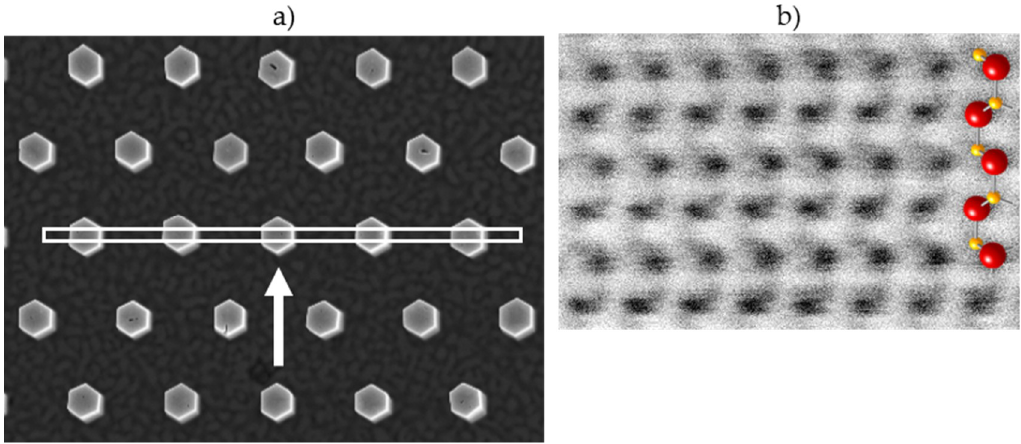
Figure 4. ( a ) Schematic of the STEM lamellae position on sample N–AlGaSL-1; the arrow indicates the STEM imaging direction. ( b ) Atomic resolution STEM ABF image showing the zone axis is [ 112 0 ] and, therefore, the lamella has { 112 0 } surfaces and the NW facets are [ 11 00 ] The atomic resolution image also shows the nitrogen polarity of the NWs.